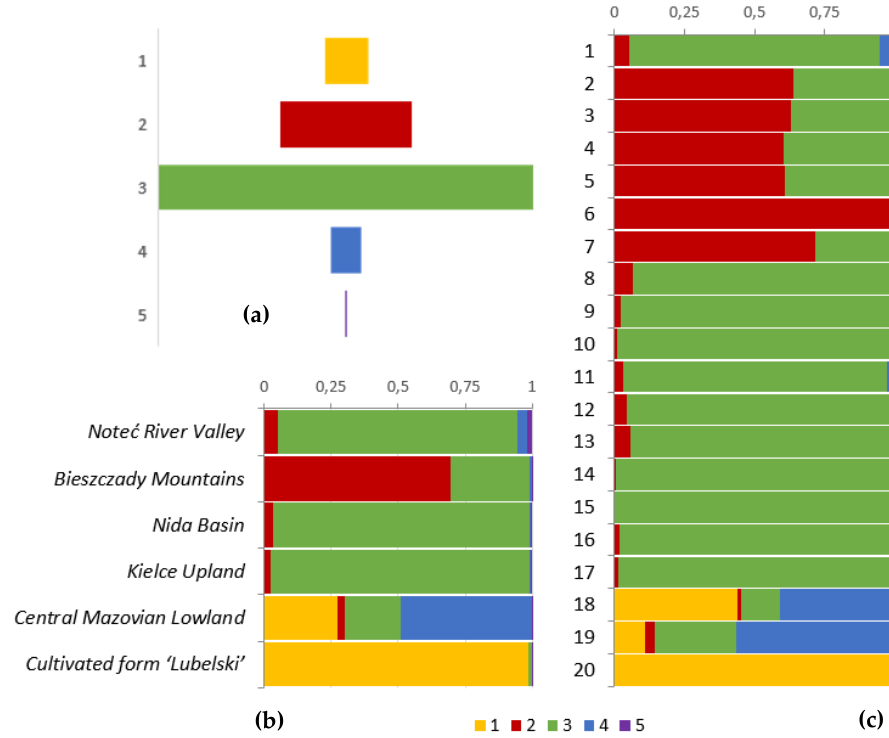
Figure 2. Results of the genetic clustering of 20 accessions of V. officinalis , based on the DArTseq derived SNPs. ( a ) Content of the individual gene pools in the investigated populations of V. officinalis .; ( b ) Bayesian inference of the population structure at K = 5, using STRUCTURE for the 20 populations. ( c ) Bayesian inference of the population structure at K = 5, using STRUCTURE for the geographic regions.